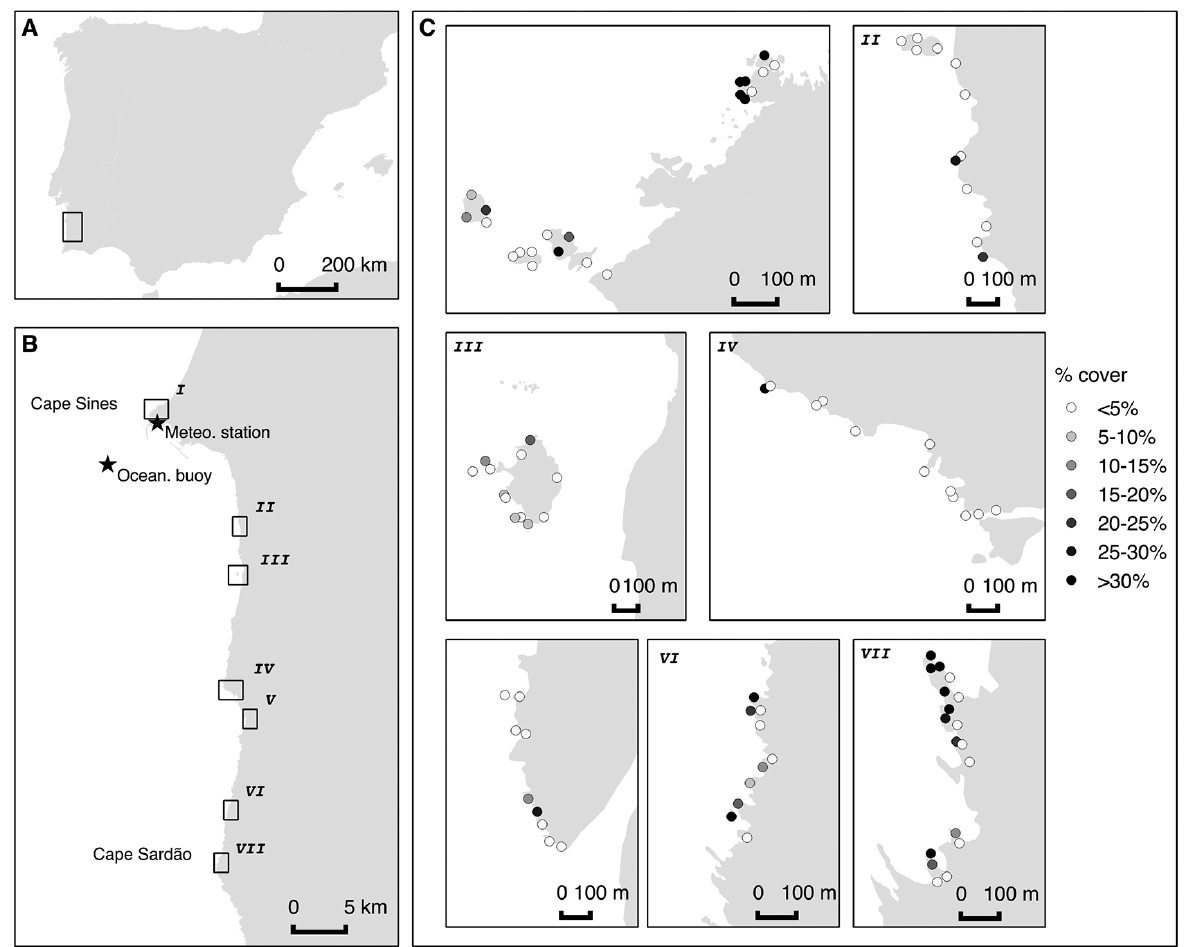
Fig. 1. – Study region in relation to the Iberian Peninsula (A) and location of sampling areas (I- VII) (B), meteorological station (Meteo. station) and oceanographic buoy (Ocean. buoy) in SW Portugal. Sampling site location and mid-intertidal Pollicipes pollicipes average percentage cover results from digital image analyses